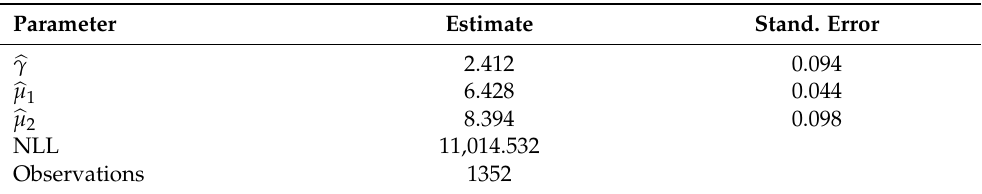
Table 3. Parameter estimates, standard errors and negative of the log-likelihood (NLL) for the model without covariates. Parameter Estimate